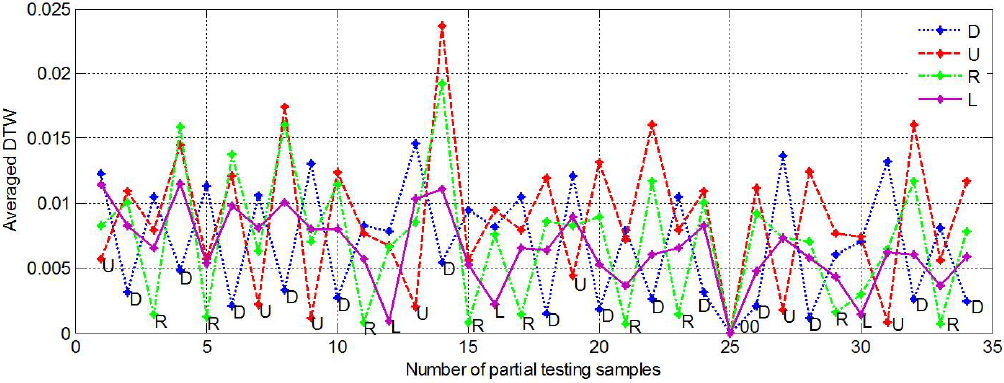
Figure 12. The movement classification results of several Chinese characters based on DTW.